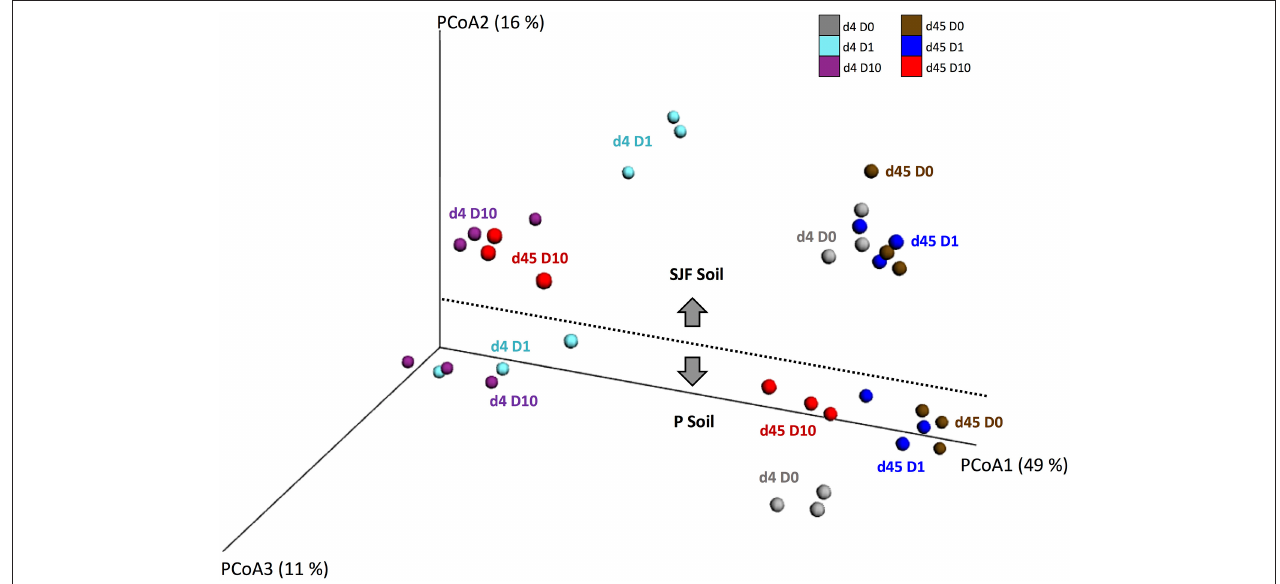
FIGURE 2 | UniFrac analysis of the effect of leptospermone applied at different concentrations (D0, D1, and D10) on the bacterial community composition of P and SJF soils at 4 and 45 days (d4, d45). The first three axes of the PCoA of the weighted UniFrac distance matrix of 16S rRNA amplicon pyrosequencing are shown. The percent of variance explained by each axis is given. For both soils, treatments are as follows: at 4 days for D0, D1, and D10 (gray, cyan, and dark violet), and at 45 days for D0, D1, and D10 (brown, blue and red).